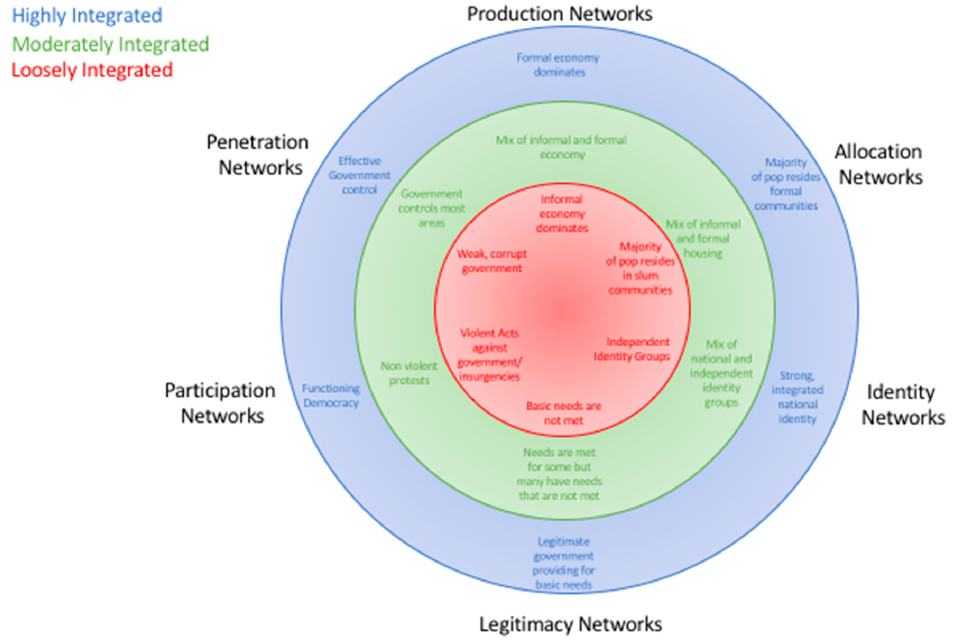
Figure 1. Conceptual model of sociocultural factors of dense urban areas.